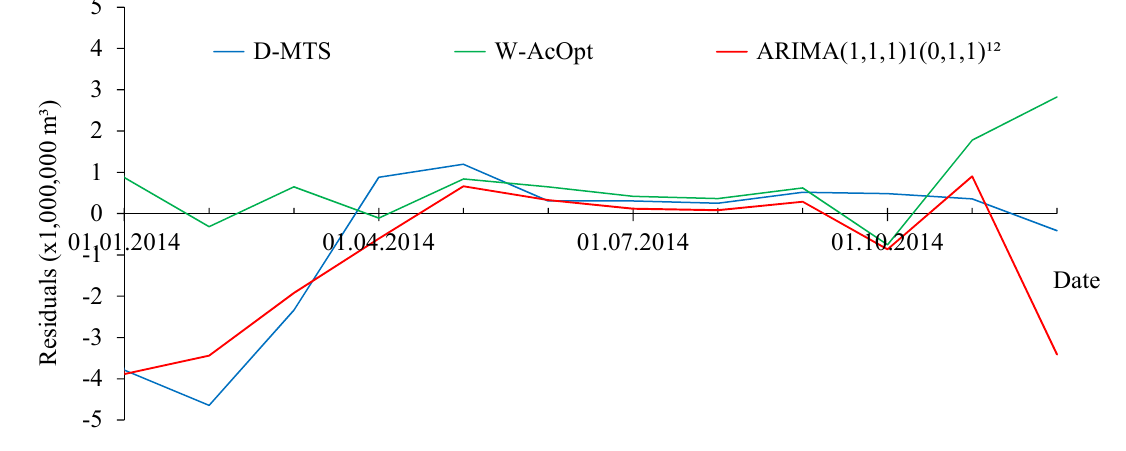
Figure 6. Residuals of Consumption for MAPE 2014 .